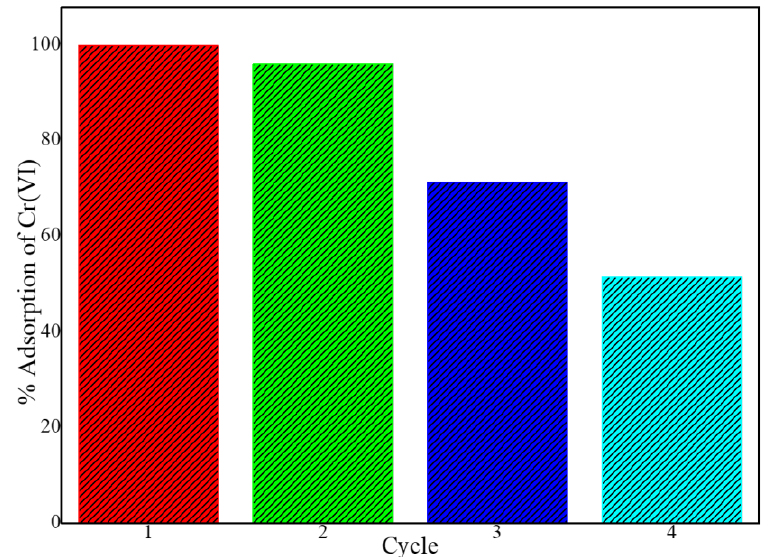
Figure 10. Adsorption cycles for Cr(VI) removal by the PPy– m PD/Fe 3 O 4 nanocomposite.